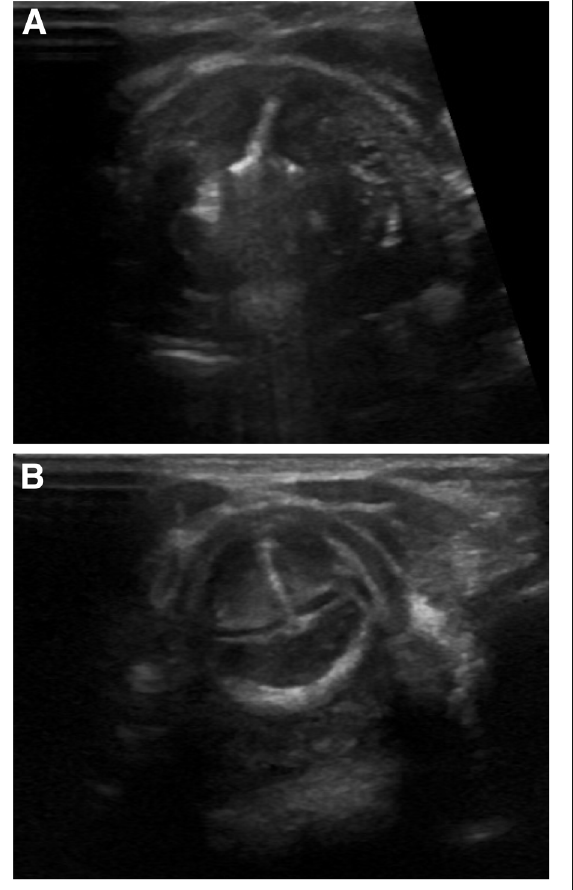
Fig. 3 B mode image at the level of the vocal cord with fine air bubble casting posterior reverberation artifact ( a ) and with no reverberation artifact ( b )